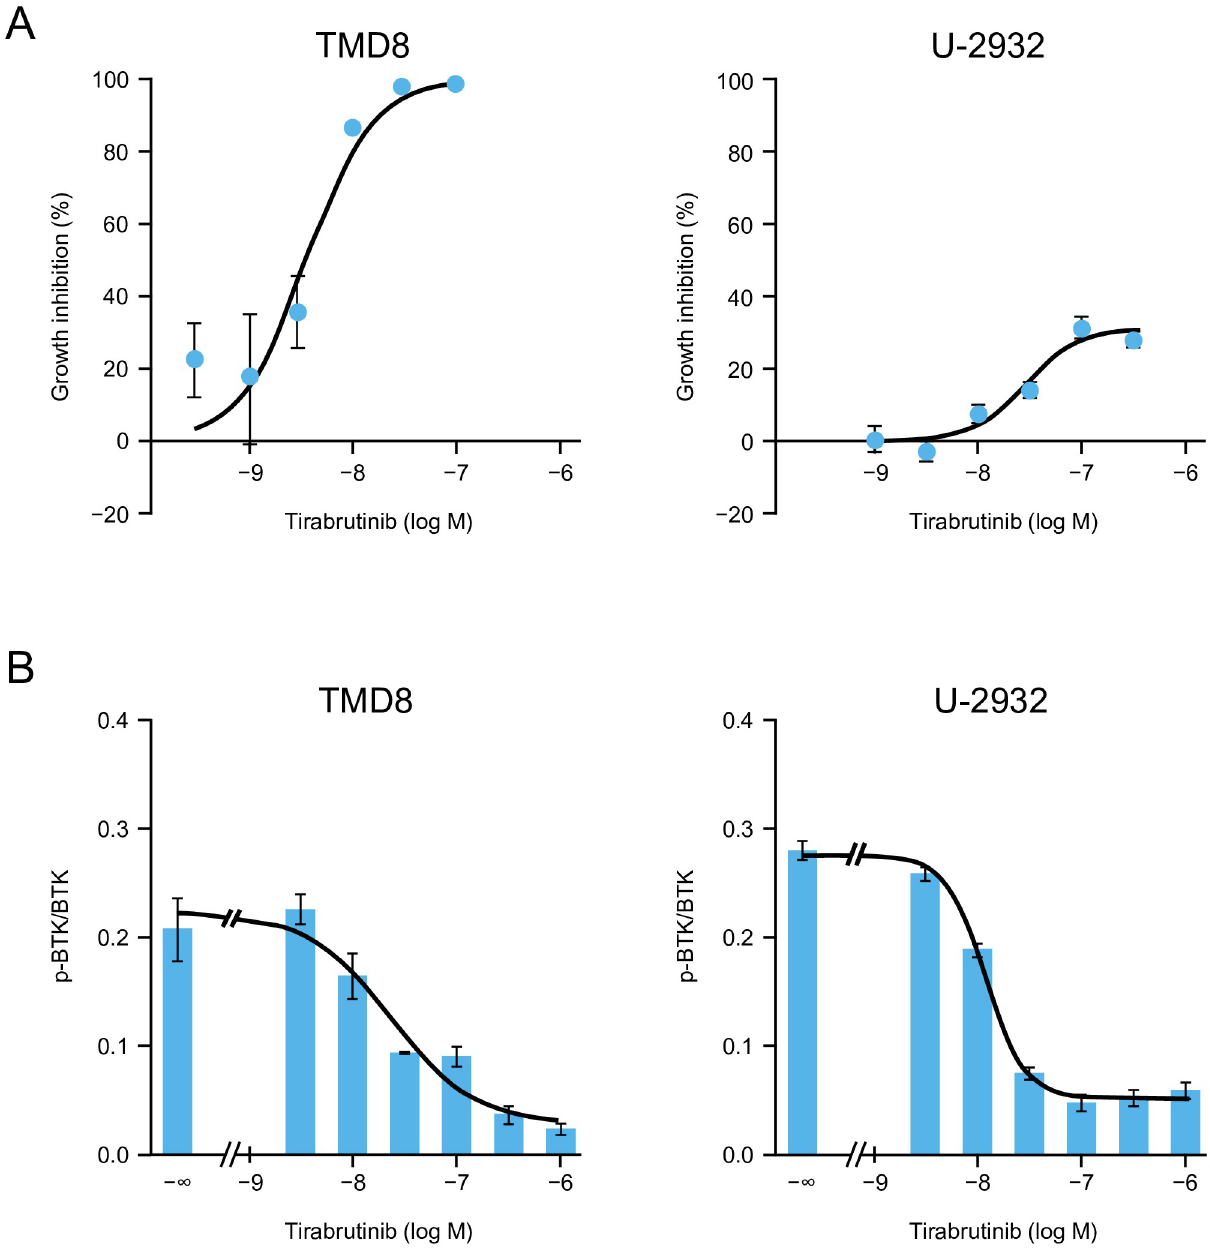
Fig 3. Antiproliferative activity (A) and BTK autophosphorylation inhibitory effects (B) of tirabrutinib. (A) TMD8 or U-2932 cells were treated with vehicle or different concentrations of tirabrutinib and incubated for 72 h at 37˚C, 5% CO 2 /95% air. After culturing, the growth inhibition rate (%) was calculated by measuring a luminescent signal proportional to the amount of intracellular ATP using the CellTiter-Glo Luminescent Cell Viability Assay. The growth inhibition rate in the tirabrutinib group is plotted as the mean of 3 or 4 treated cultures from each treatment group ± standard error for TMD8 or U-2932, respectively. (B) TMD8 or U-2932 cells were treated with vehicle or different concentrations of tirabrutinib and incubated for 4 h at 37˚C, 5% CO 2 /95% air. Autophosphorylated BTK (p-BTK) and total BTK (BTK) proteins were detected by western blot analysis. The intensity of each western blot band shown in S1 Fig was determined. The ratio of phosphorylated to total BTK is described as the mean of three cases ± standard error in the bar chart. The symbol - 1 indicates the vehicle group. The curve was estimated by nonlinear regression analysis using a four-parameter logistic model. BTK, Bruton’s tyrosine kinase.